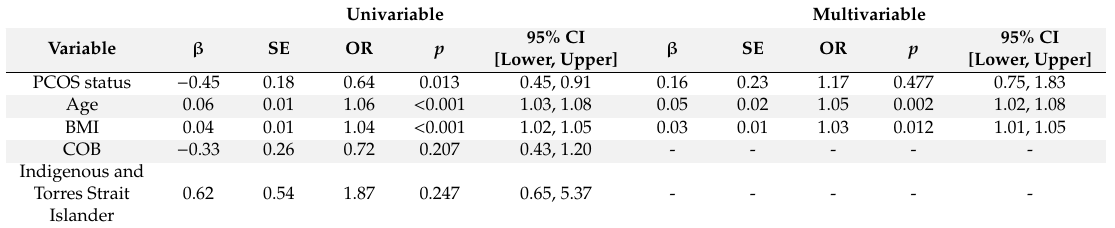
Table 3. Factors associated with disordered eating in women with and without PCOS. Univariable